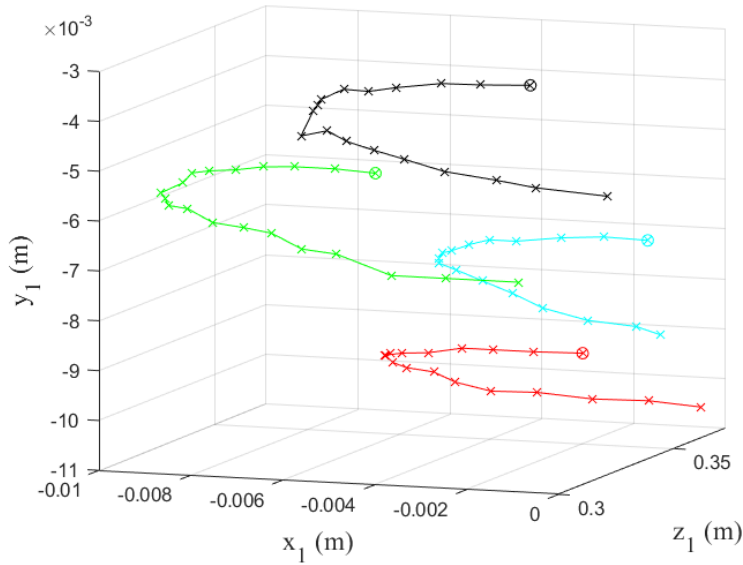
Figure 8. 3D-tracking of the 4 particles selected in Figure 7. (trajectories of particles 1, 2, 3, and 4 in red, green white and cyan respectively).